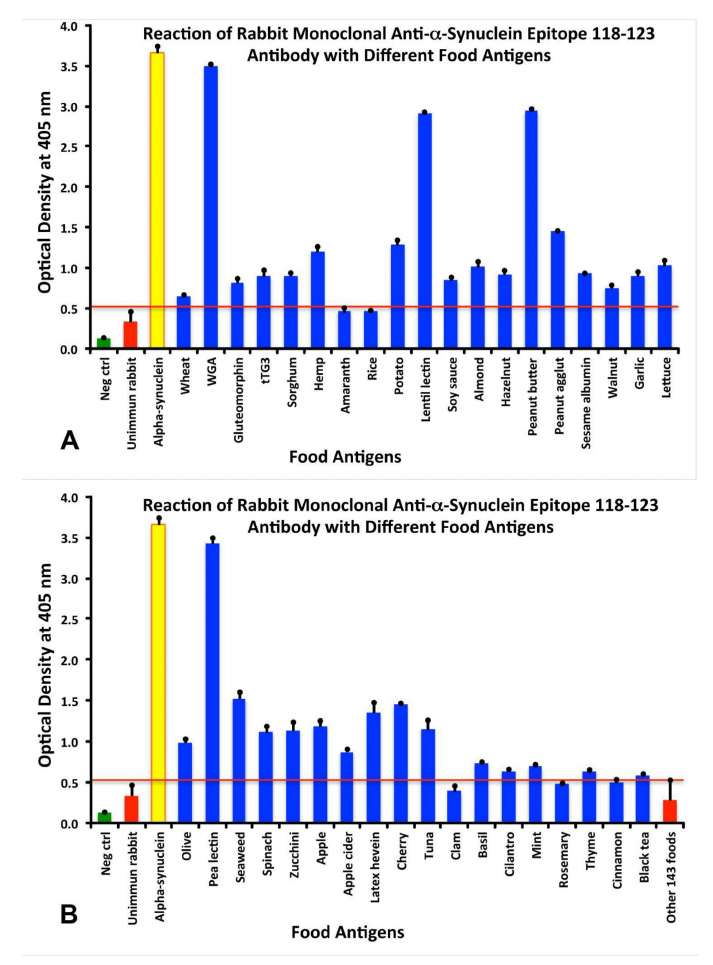
Figure 2. ( A , B ) Reaction of rabbit monoclonal antibody made against anti-epitope 118–123 with different food antigens. WGA—wheat germ agglutinin, tTG3—tissue transglutaminase